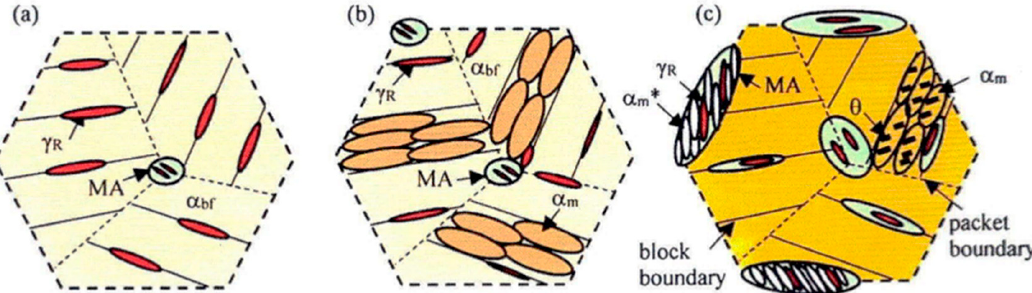
Figure 3. Illustration of the typical microstructure of various third-generation AHSSs [81]. ( a ): TBF, CFB, and BF-MMn steels ( T IT > M s ); ( b ): TBF, CFB, one-step Q&P, and BF-MMn steels ( T IT = M s − M f ), and two-step Q&P and two-step Q&P-MMn steels ( T P > M s ); ( c ): TM and M-MMn steels ( T IT < M f ). α bf , α m , α m *, γ R , θ , and MA represent bainitic ferrite, primary coarse soft martensite, secondary fine hard martensite, retained austenite, carbide, and MA phase (a mixture of α m * and film-like γ R ), re- spectively.